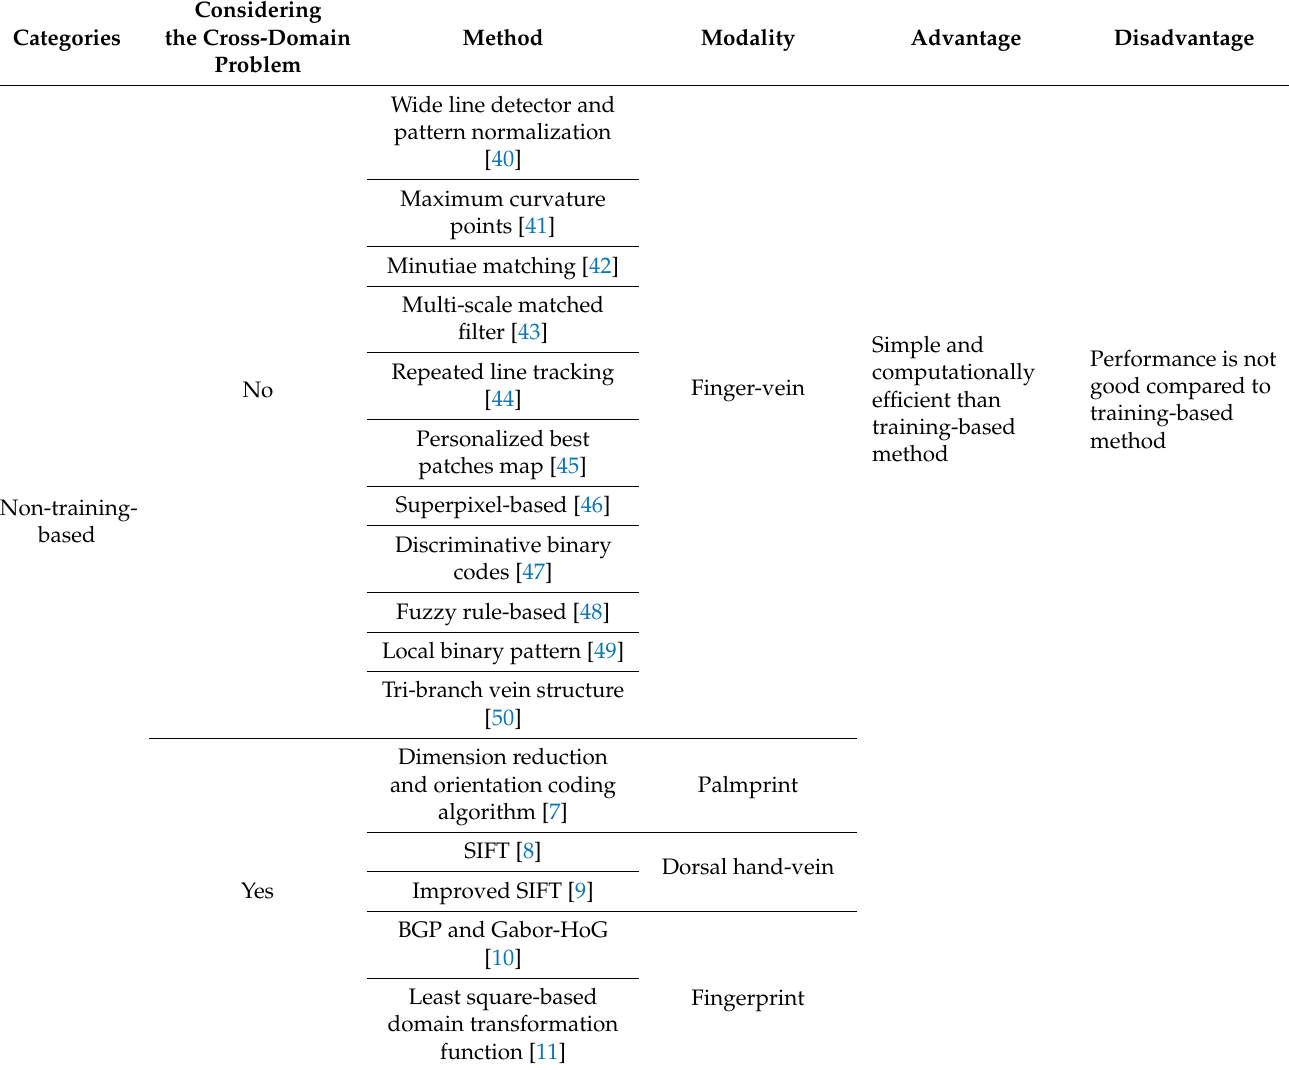
Table 12. Comparisons of the previous and proposed methods for hand-based